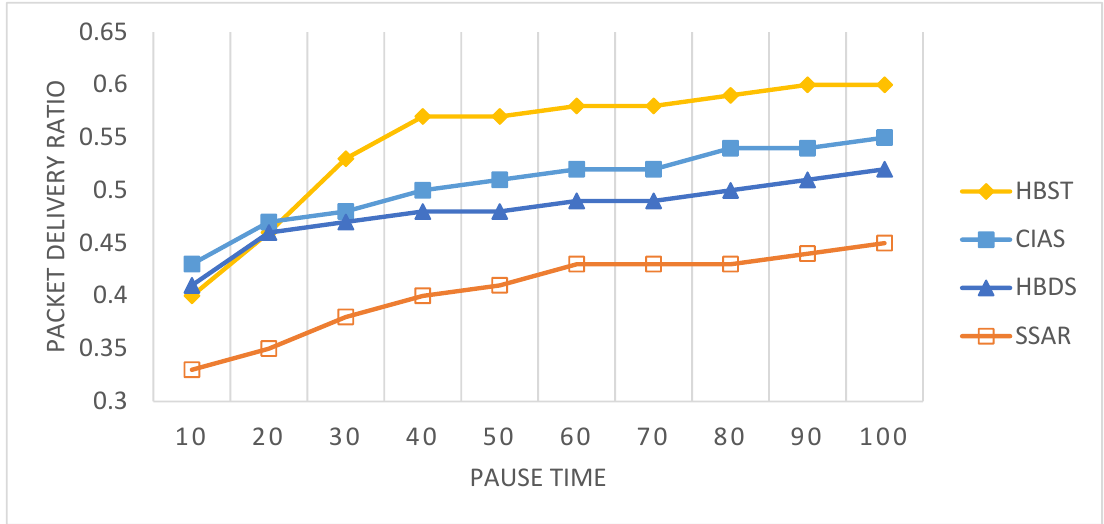
Figure 8. Packet delivery ratio for the network with 50% selfish nodes.